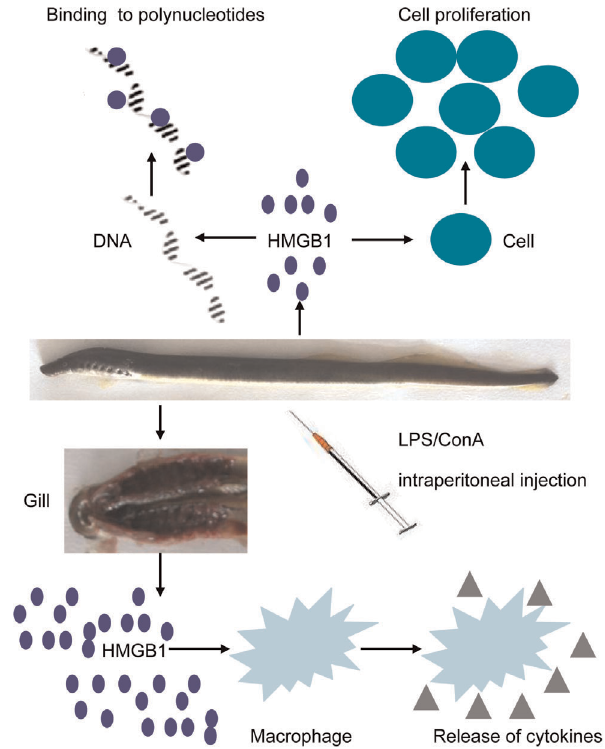
Figure 9. Model of the functions of lamprey HMGB1. Lamprey HMGB1 has various roles, such as binding DNA, which may maintain DNA structure, and inducing cell proliferation, which may promote the evolutional stability of the parasitic lamprey. After LPS/ConA stimula- tion, the Lj-HMGB1 gene was up-regulated in gills, which in turn promoted the release of proinflammatory mediators, such as TNF- a , to alert the lampreys to underlying danger and prevent the invasion of bacteria or viruses or other exogenous